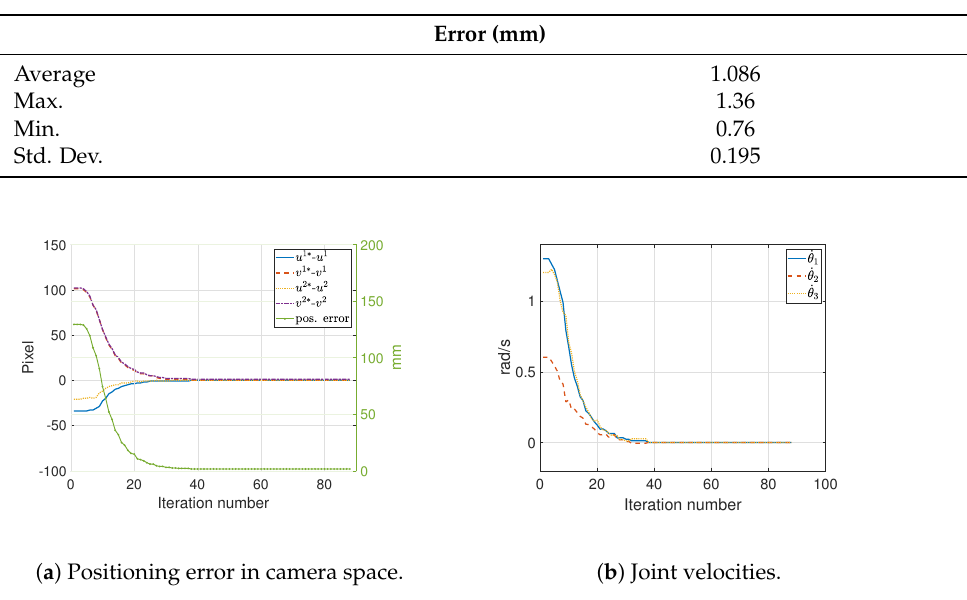
Figure 6. Error in camera space and joint velocities during a typical static positioning